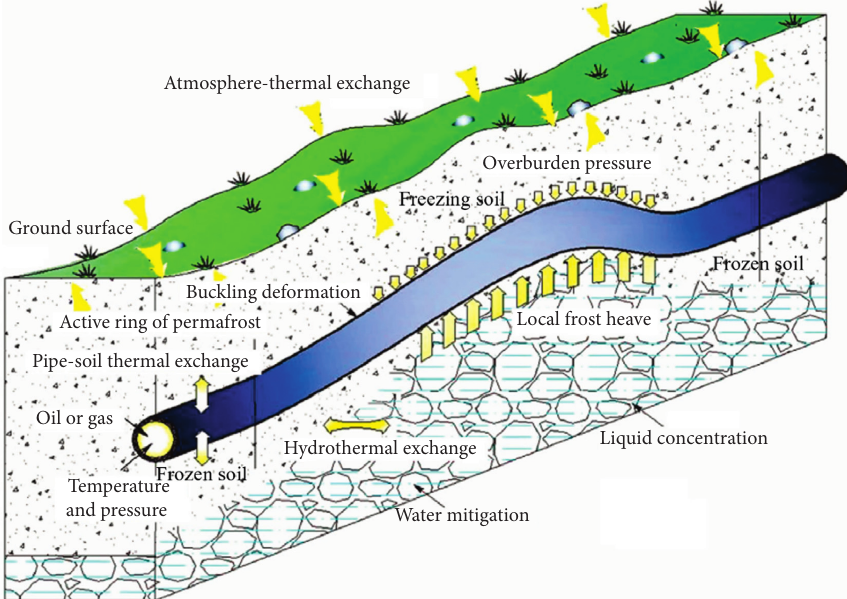
Figure 7: Schematic of pipeline subjected to frost heave displacement load [31].